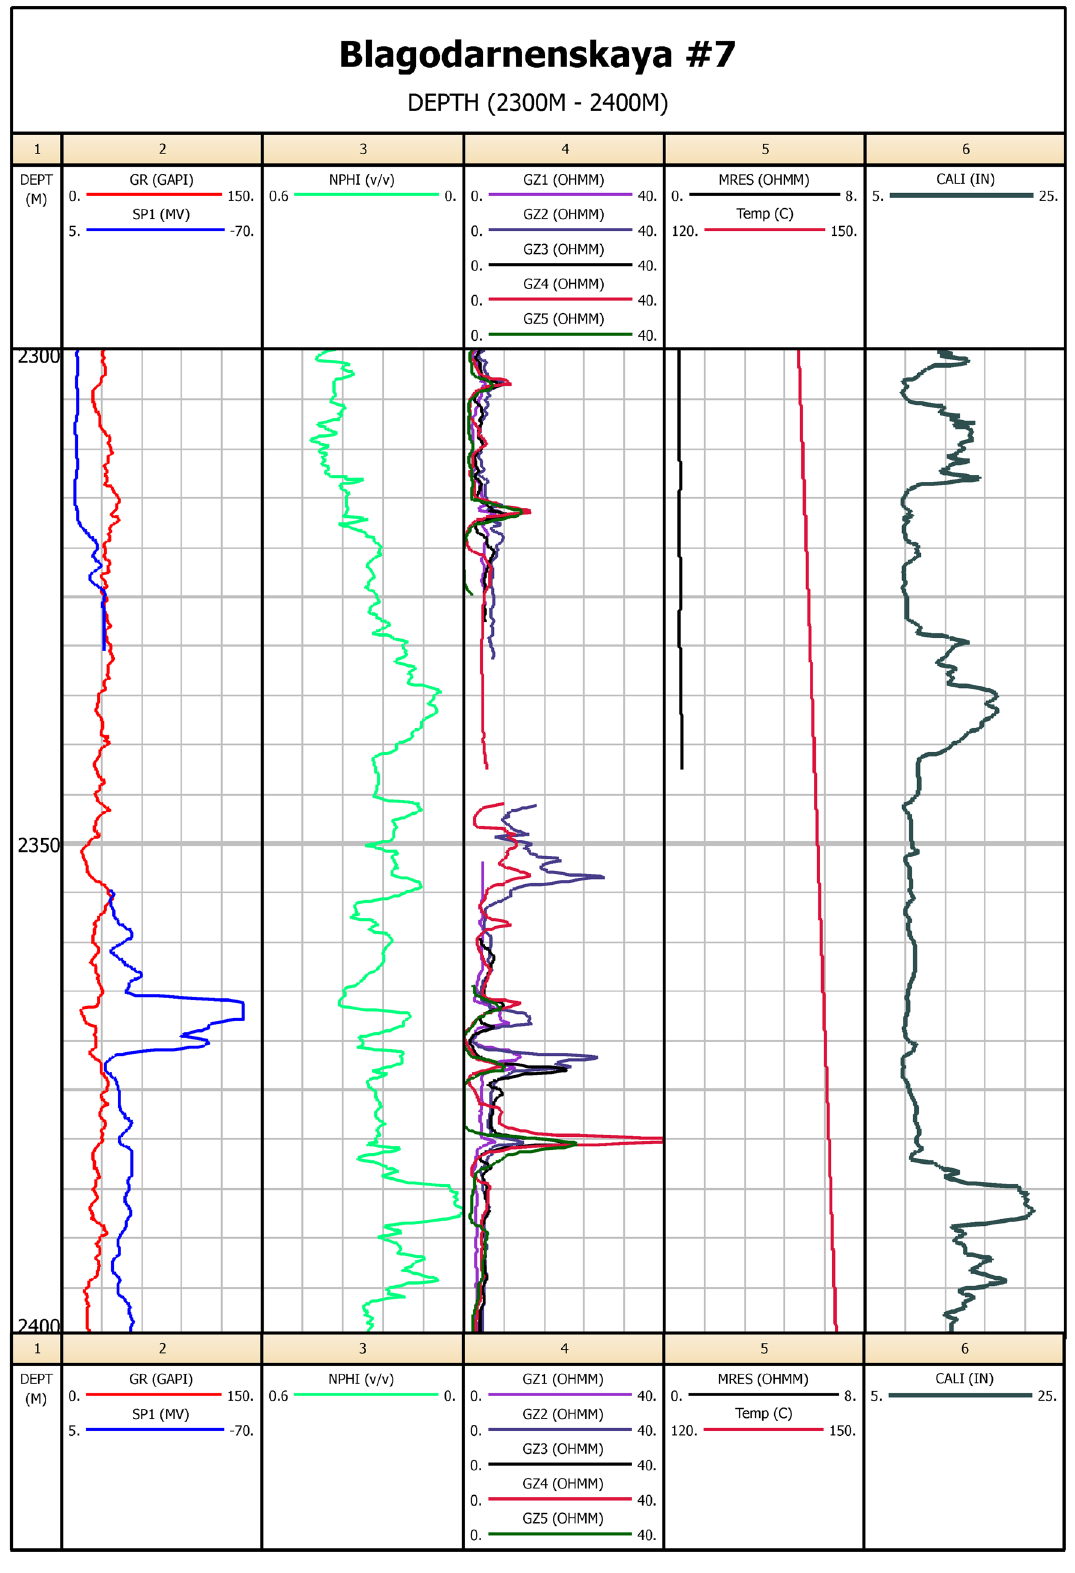
Fig. 2 Wireline logs for the Well # 7